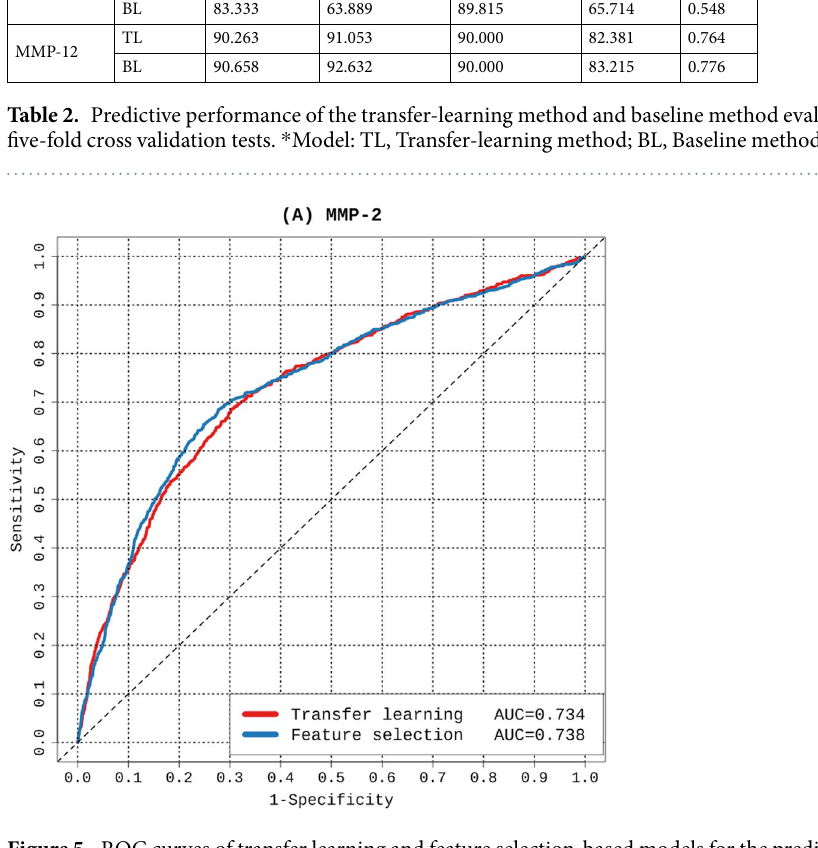
Figure 5. ROC curves of transfer learning and feature selection-based models for the prediction of substrate- cleavage sites for MMP-2. The results were evaluated based on independent test.